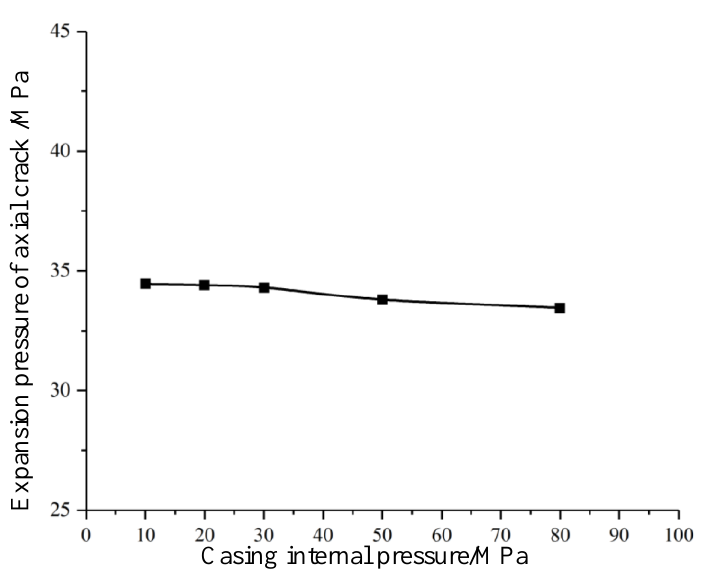
Figure 20. The effect of casing internal pressure on the pressure of the crack opening.